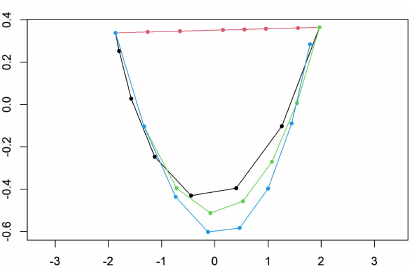
Figure 8. Trend of the energies for different interpolations: ( a ) Left: linear interpolation ( b ) Center: geodesics interpolation. ( c ) Right: autoparallel interpolation. Blue refers to d u , red to d b , grey to d tot .